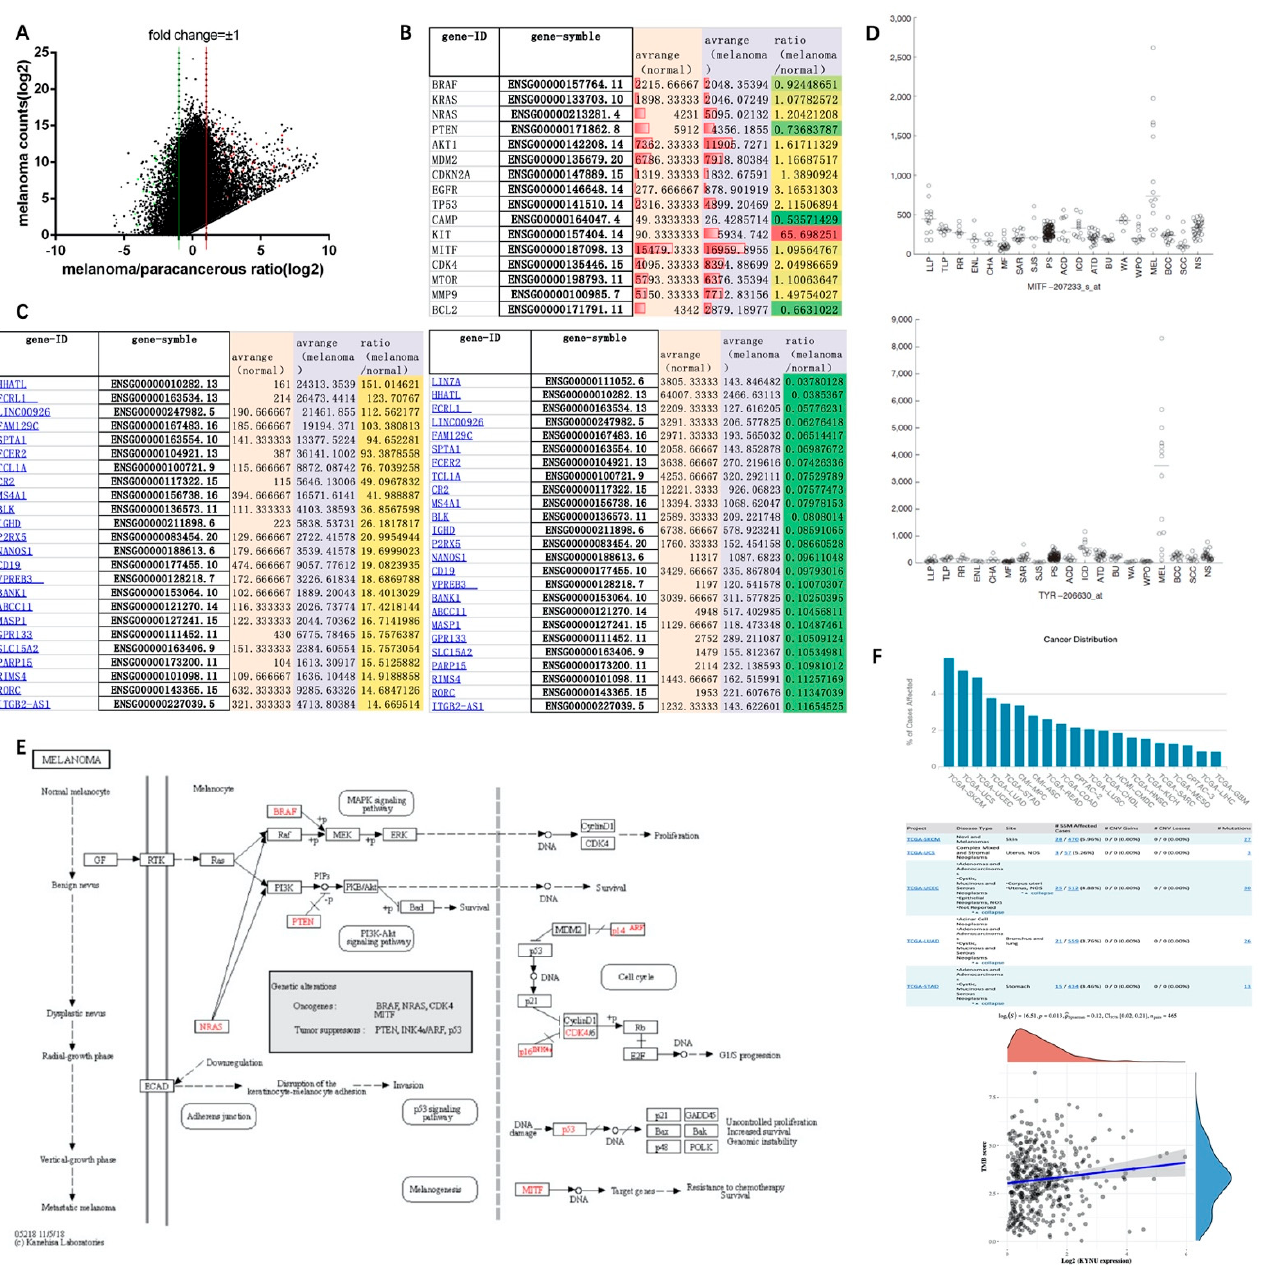
Figure 1. Screening of differentially expressed genes and signaling pathway mechanism of melanoma in TCGA database: ( A ) tumor-associated gene expression changes in melanoma samples from TCGA database; ( B ) gene expression of melanoma marker genes in TCGA database; ( C ) top 25 genes with significantly increased or decreased expression in melanoma compared with solid tissue normal samples after screening in TCGA database; ( D ) the expression levels of MITF and TRY are specifically elevated in melanoma; ( E ) melanoma signaling pathways in the KEGG database; ( F ) mutation distribution of KYNU in tumors from TCGA database.